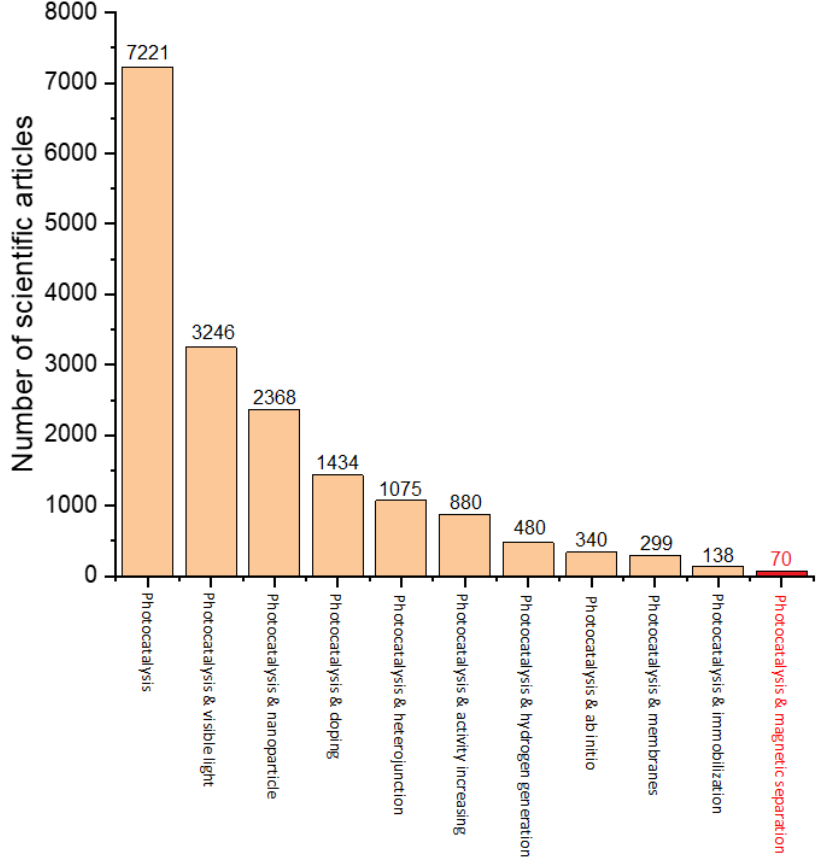
Figure 1. The number of scientific articles published in 2020 (according to the Web of Science database) for various keywords concerning photocatalysis.